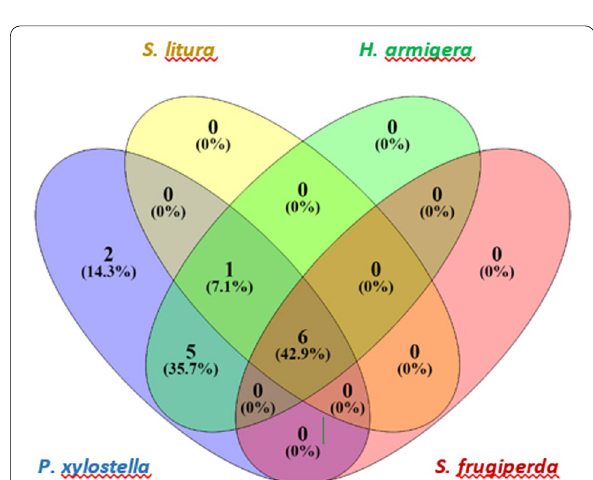
Fig. 5 Distribution of indigenous Bt isolates producing 100 per cent mortality in four species of lepidopteran